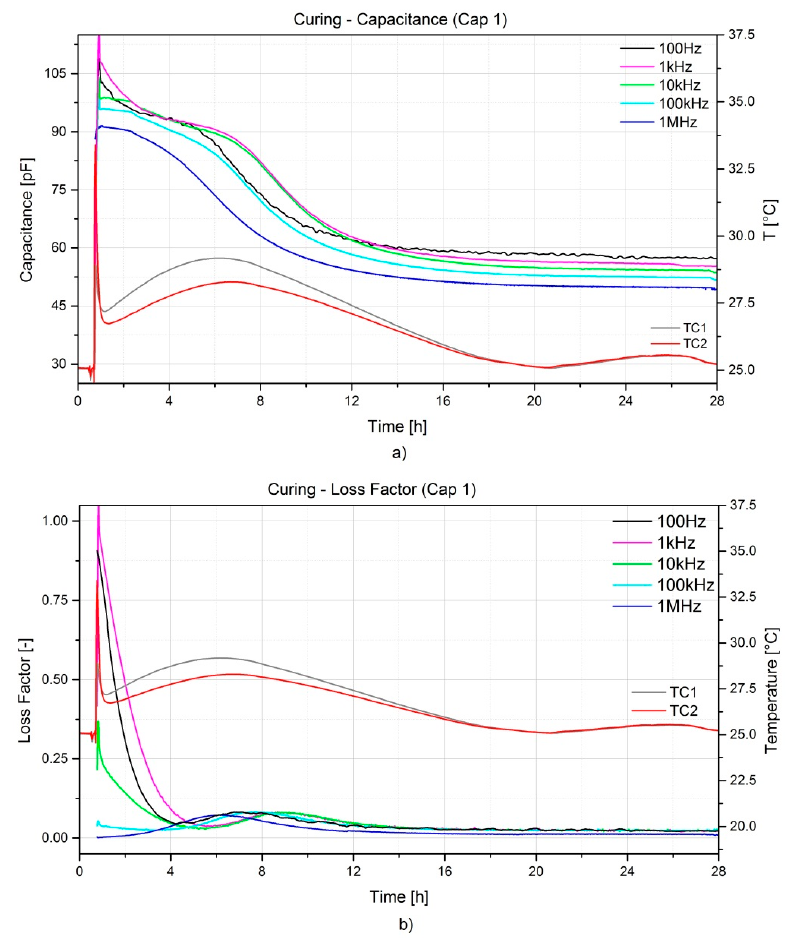
Figure 6. Capacitance ( a ) and loss factor ( b ) evolution during the RTM process of the A380 hinge arm.